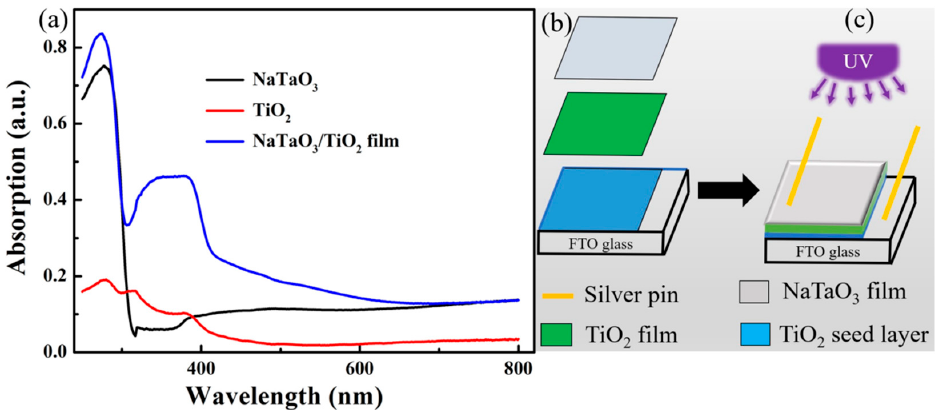
Figure 4. ( a ) The absorption spectrum of pure NaTaO 3 , TiO 2 and the NaTaO 3 /TiO 2 composite film; ( b , c ) the device structure diagram of the composite-film-based